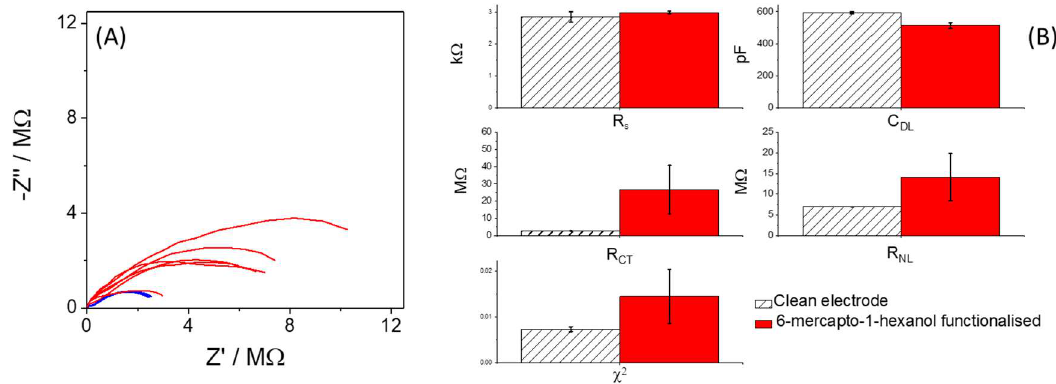
Figure 5. ( A ) EIS plots recorded in 2.5 mM ferri-ferrocyanide + 1 mM potassium chloride + 100 mM potassium nitrate. ( B ) Mean and Standard Deviations (Bars) associated with the parameters obtained from equivalent circuit fitting (R S , C DL , R CT , R NL and global χ 2 ) for clean and chemically modified microelectrodes (n = 6), recorded in 1.0 mM ferri-ferrocyanide + 1 mM potassium chloride + 100 mM potassium nitrate. N = 6 and error bars represent standard deviation.